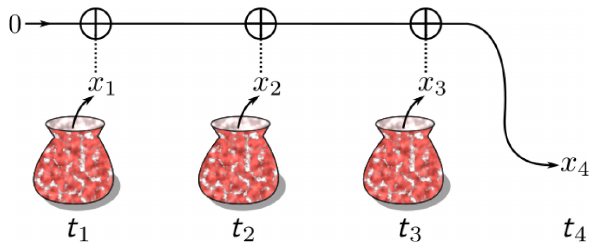
FIG. 7. Stroboscopic divisible non-Markovian process. At each time t j , each of the possible outcomes 0 and 1 occurs with probability 1 / 2 (for example, they could be drawn from urns with uniform distributions). At the final time t 4 , the observed outcome is equal to the sum (modulo 2) of the previous three outcomes. While the stochastic map between any two points in time is com- pletely random—and thus the process is divisible—the overall joint probability distribution shows multitime memory effects (as laid out in the